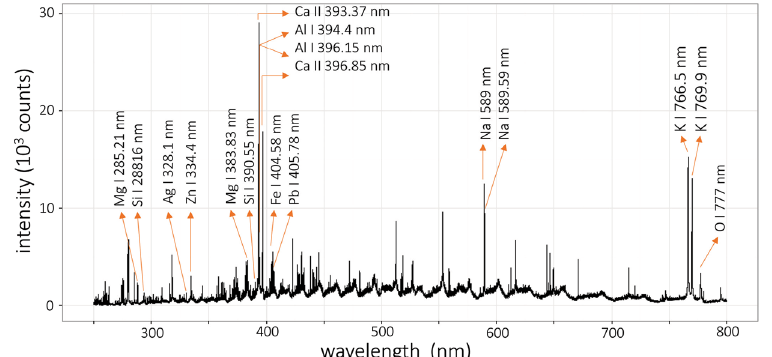
Figure 1. LIP spectrum of the O131b sample.